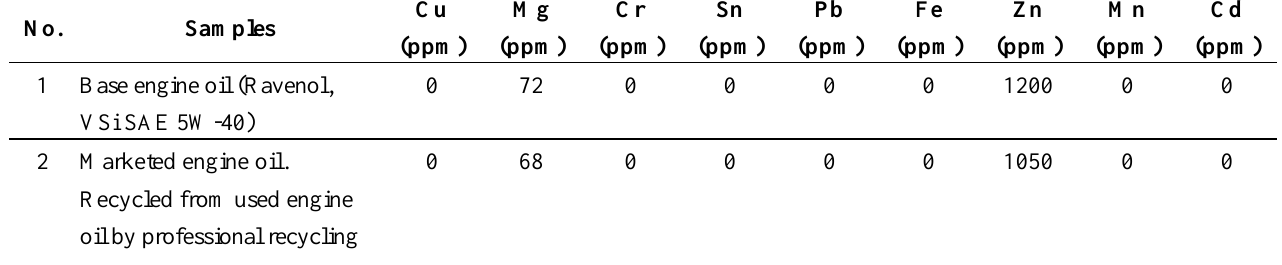
Table 4. Analysis results of metal content of different